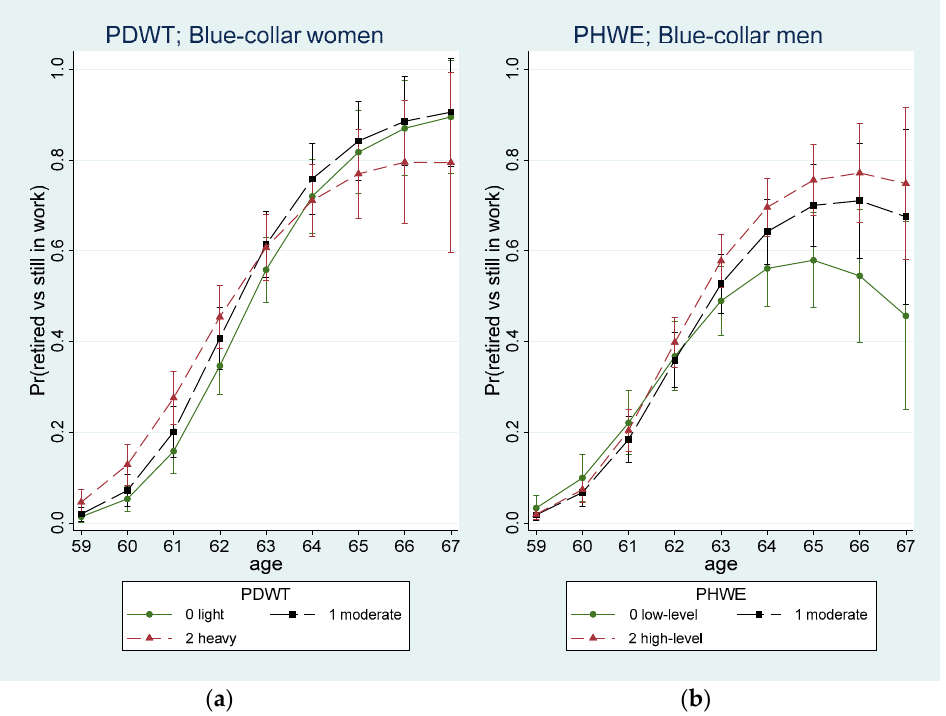
Figure 1. Predictive marginal probability (and 95% CI) of retiring (vs. still in work) at 2-year follow-up by age and ( a ) PDWT for all blue-collar women; ( b ) PHWE for blue-collar men.